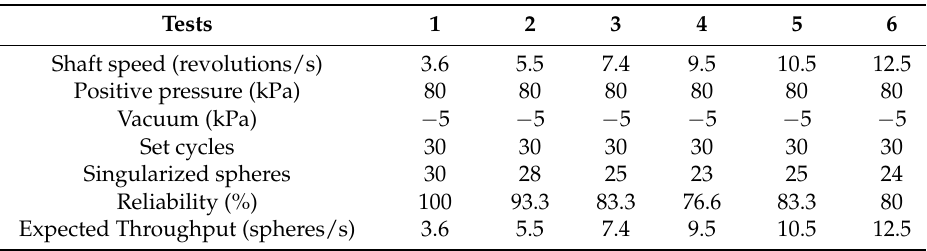
Table 2. Results of the singularization tests with 0.6 mm